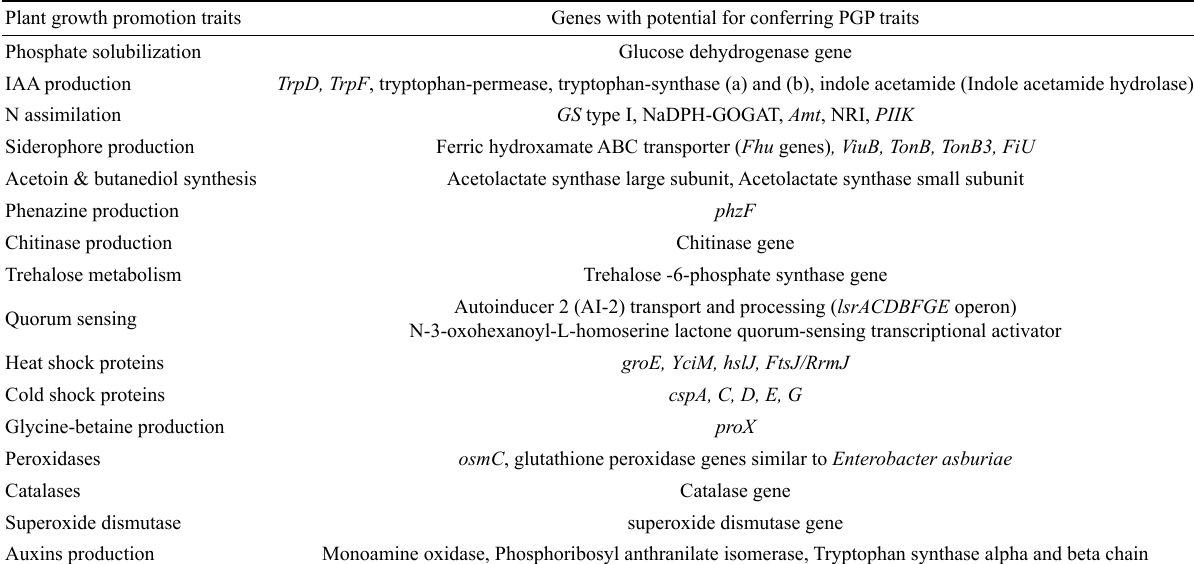
Table 4 – List of genes attributable to plant growth promotion traits in L adecarboxylata